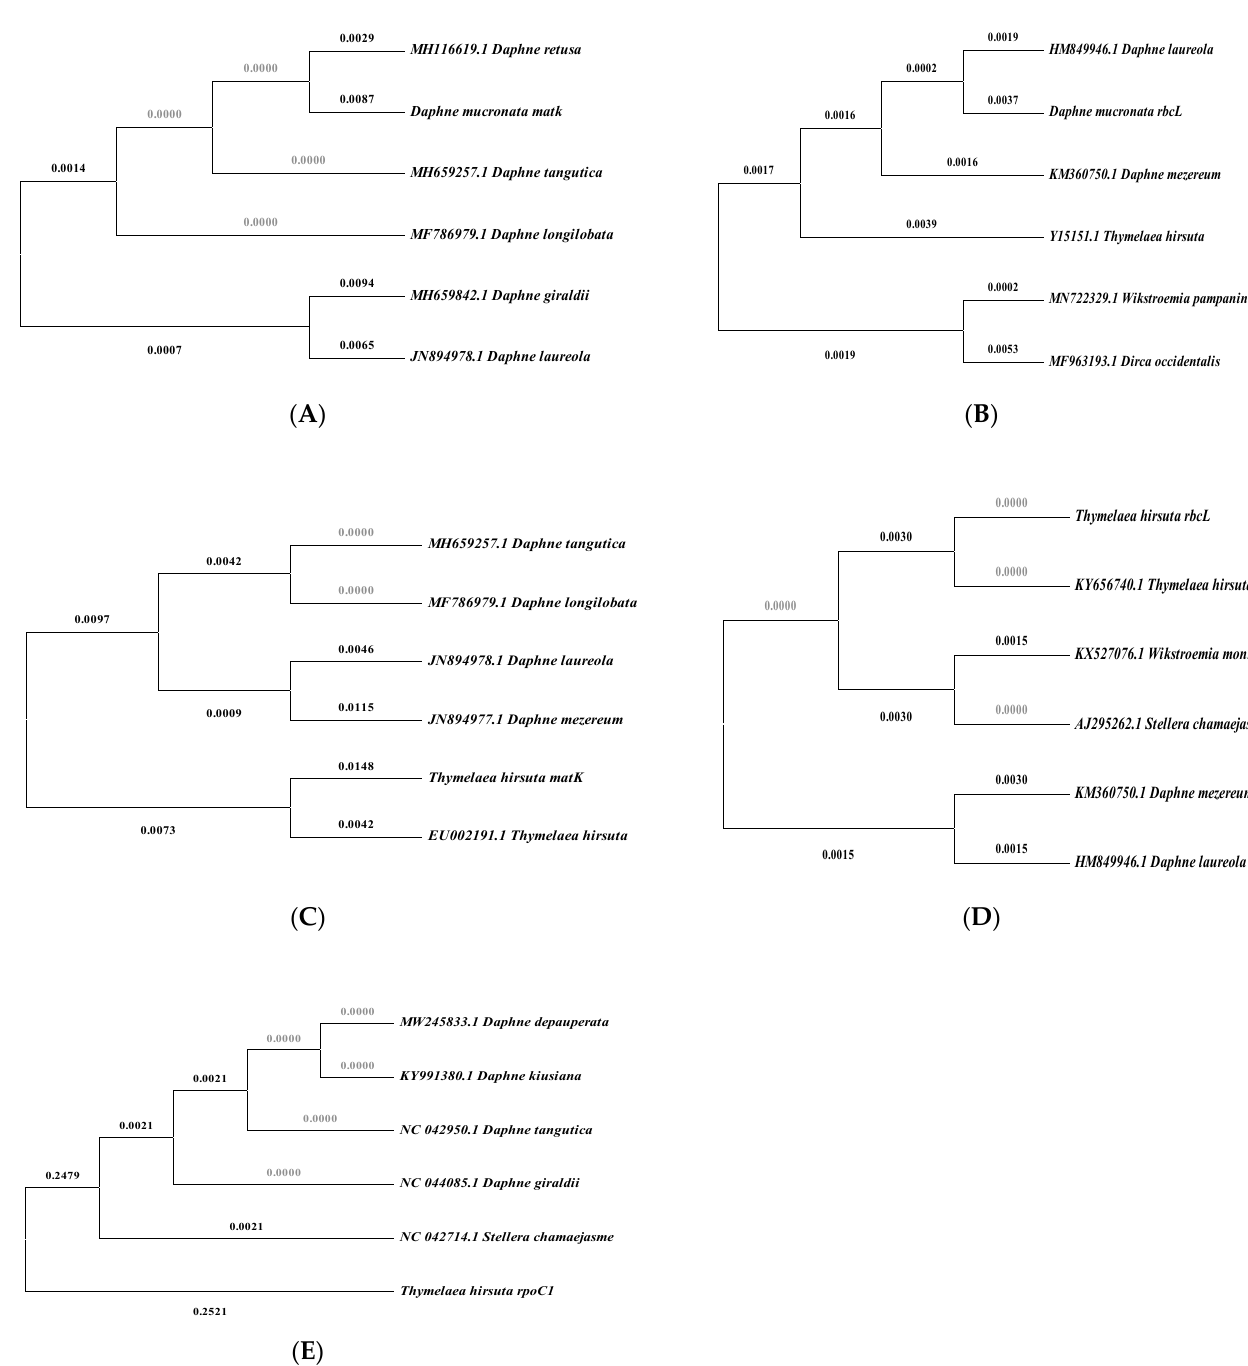
Figure 2. The phylogenetic trees (Neighbor-Joining method) of the top five related species and obtained barcode sequences of Thymelaea hirsuta and Daphne mucronata . ( A ) Daphne mucronata matK , the sum of branch length is 0.02958153; ( B ) Daphne mucronata rbcL , the sum of branch length is 0.02199074; ( C ) Thymelaea hirsuta matK , the sum of branch length is 0.05720029; ( D ) Thymelaea hirsuta rbcL , the sum of branch length is 0.01331361; ( E ) Thymelaea hirsuta rpoC1 , the sum of branch length is 0.50635593.